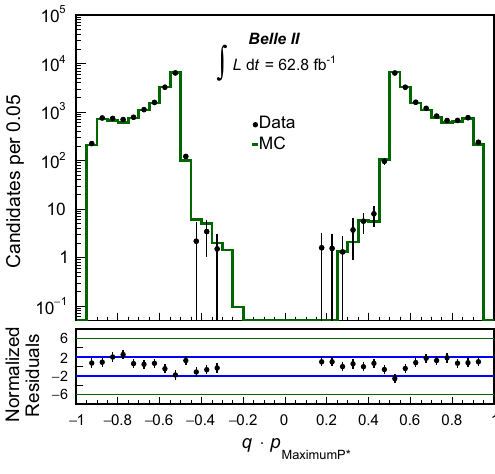
∗ category ( ∗ ) − + h candidates. The contri-